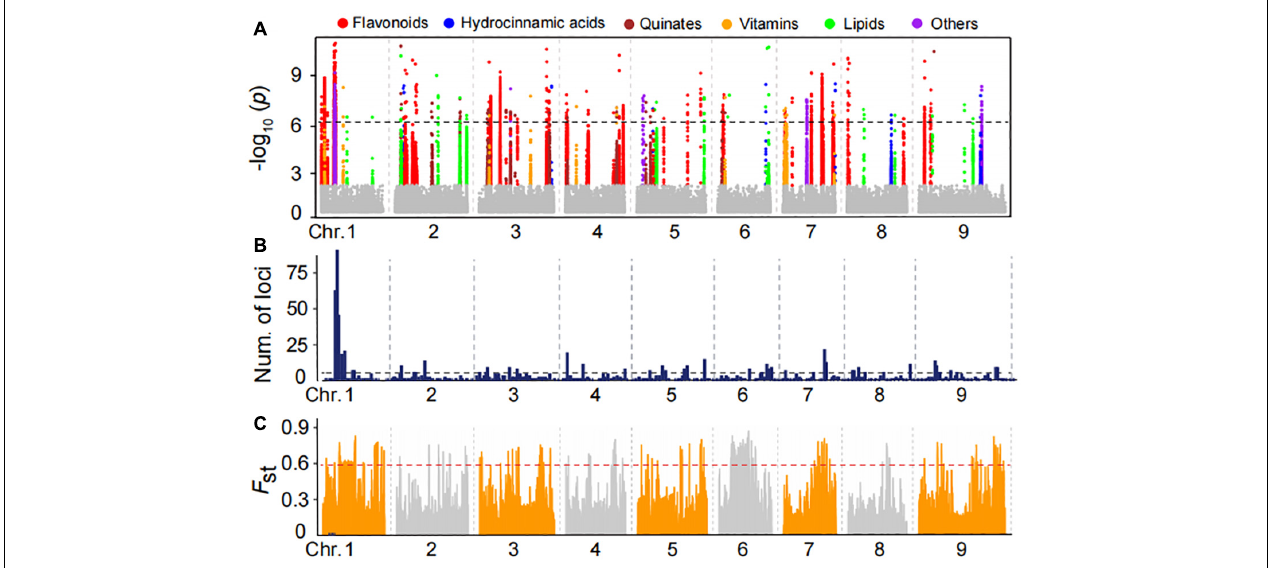
FIGURE 3 | Manhattan plots of mGWAS results and genetic differentiation of mGWAS loci between Indian and Chinese millet. (A) Manhattan plots of mGWAS results with the genetic association for the leaf metabolic features in millet. The strength of association for the metabolites is indicated as the negative logarithm of the p -value for the LMM model. All metabolite-SNP associations with P -values below 1.8E–06 are plotted against genome location in intervals of 1 Mb. (B) Distribution of mGWAS signals across the millet genome. (C) Distribution of differentiation ( F ST values) from the comparison of the Indian and northern Chinese millet populations. The regions above the dashed line in the F ST values distribution are in the 5% right tail of the empirical distribution ( F ST is